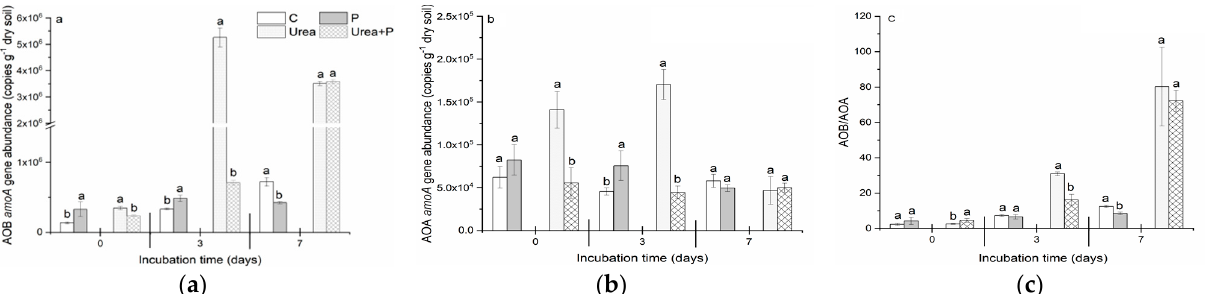
Labile N:P ratio in soils treated with urea (urea, 0.20 g N kg − 1 soil), monopotassium phosphate (P, 0.087 g P kg − 1 soil), urea plus monopotassium phosphate (Urea + P, 0.20 g N kg − 1 soil + 0.087 g P kg − 1 soil) and without any fertilizers (C, control). Three soil samples in each treatment were taken after 0, 1, 2, 3, 5, 7 and 10 days of incubation. Data in the table represent means ± standard deviations ( n = 3). Data between C and P, urea and urea + P followed by different letters in the same column are statistically different according to Fisher’s least-significant difference test ( p ≤ 0.05), i.e., a and b indicated the significant differences between two treatments, whereas a and a indicated no significant differences between two treatments. AP, available P.